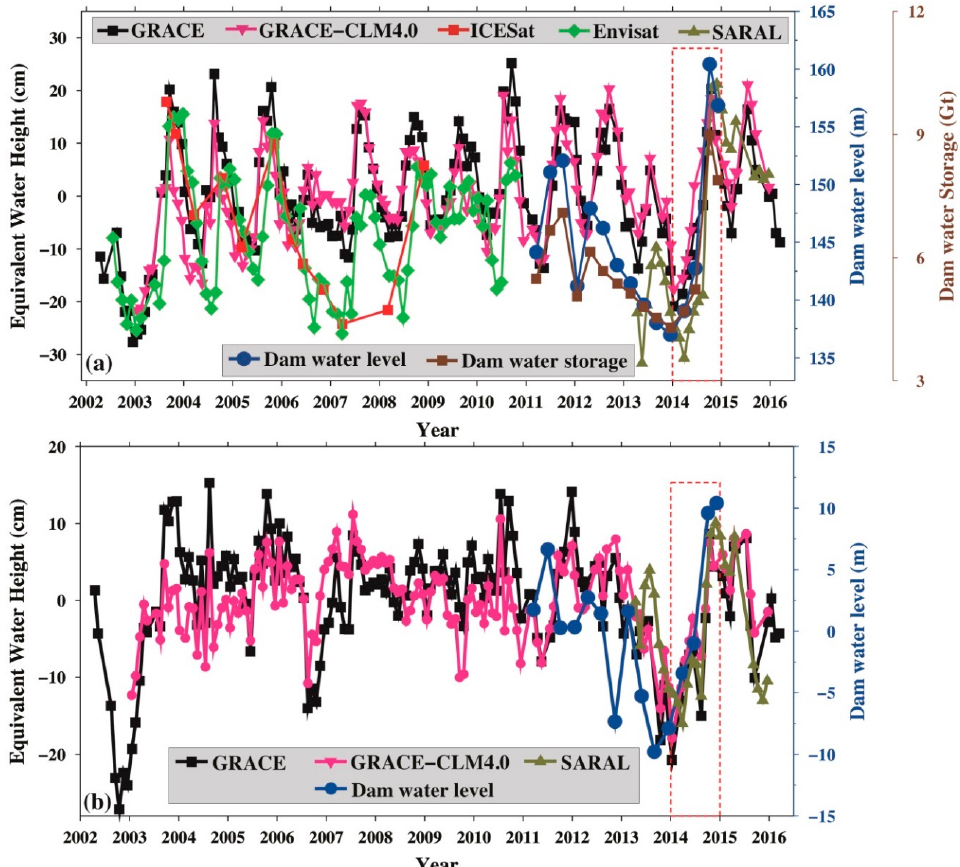
Figure 5. ( a ) Changes in the water level and storage from multi-source altimetry missions, in situ (DJKD), Gravity Recovery and Climate Experiment (GRACE), and CLM4.0 data; ( b ) the non-seasonal signal from GRACE, SARAL/Altika altimetry, and in situ (DJKD) water-level change.